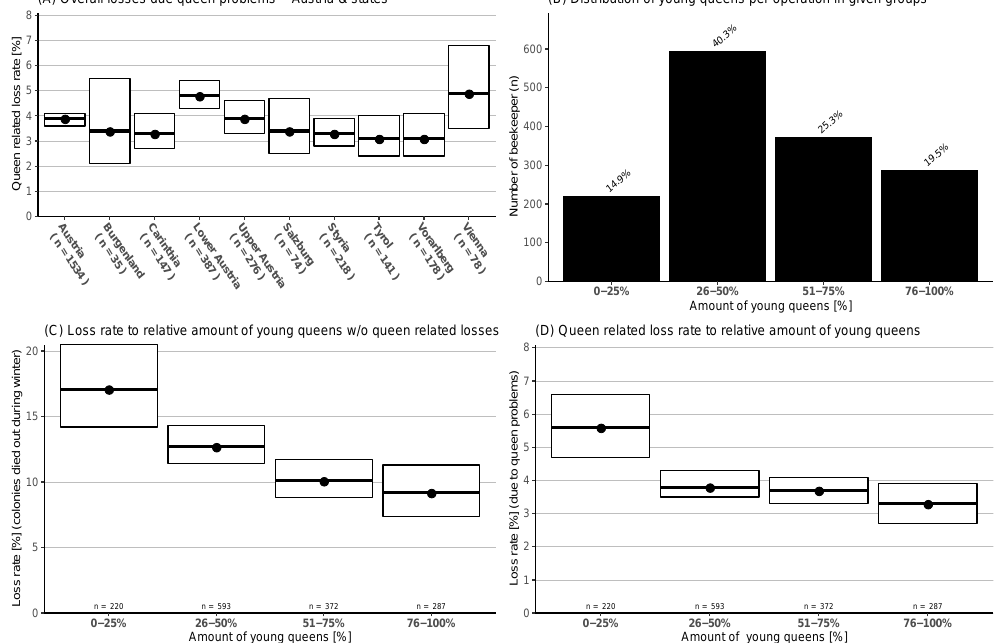
Figure 4. ( A ) Queen-related losses (and 95% CI) for Austria and its states. ( B ) Distribution of survey participants who replaced their old queens in four categories. ( C ) Categorized relative number of young queens and their winter honey bee colony loss rates (and 95% CI) without queen-related losses. ( D ) Categorized relative number of young queens and queen-related loss rate (and 95%